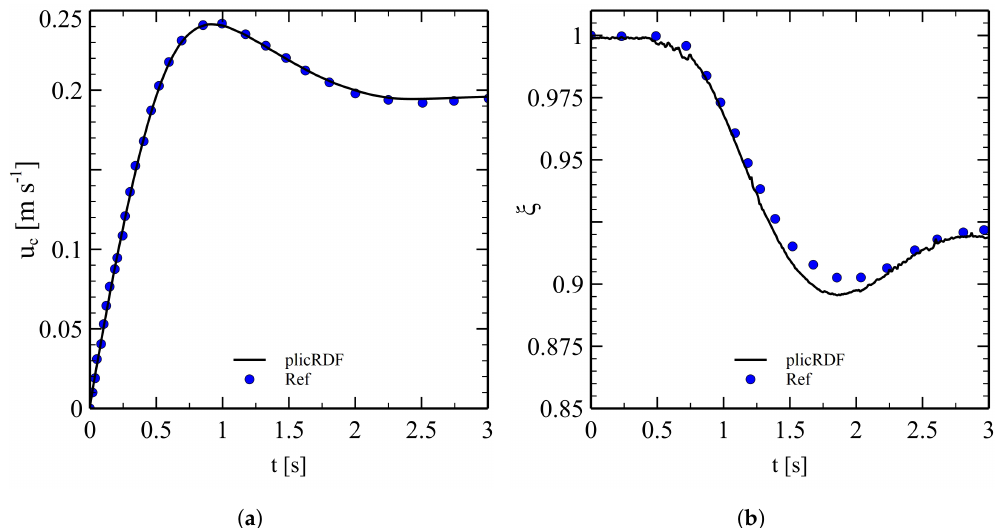
Figure 4. Evolution of u c ( a ) and ξ ( b ) for the C1 case provided by plicRDF on M4 mesh compared with Ref.